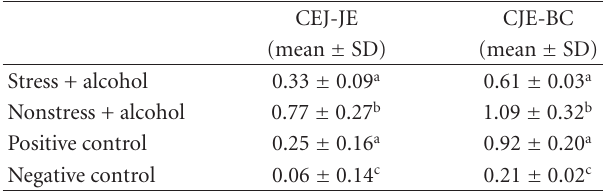
Figure 2: Image captured from the same animal illustrated in Figure 1 (alcohol associated with stress group–GASL) before per- iodontitis induction. Table 1: Mean values (mm) of loss of histological attachment (CEJ- JE) and bone loss (CEJ-BC) for the di ff erent